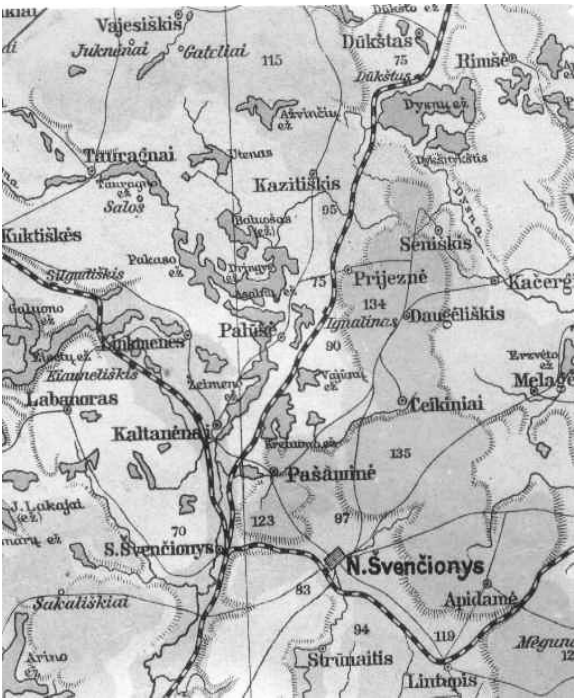
Fig 2. Map of upland and slope of relief of Lithuania and border zone. 1: 630 000